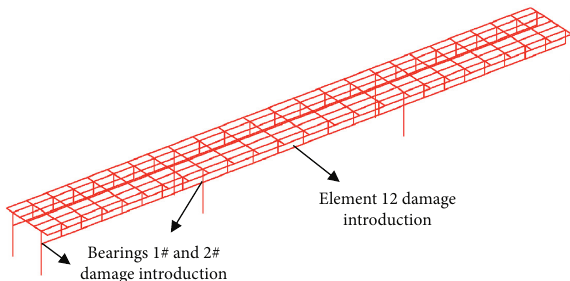
Figure 17: The finite element model of the I-40 bridge.